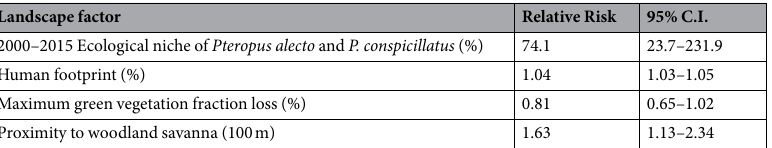
Table 3. Adjusted relative risks and 95% confidence intervals for the associations between Hendra virus spillover incidents and each landscape feature. These measures of association are derived from an inhomogeneous Poisson model of the point process of spillovers wherein each landscape factor is adjusted for all